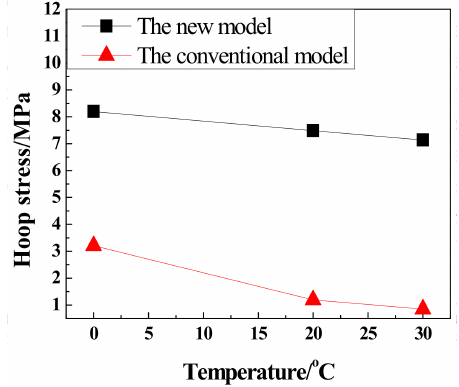
Figure 7. Hoop Stress of cement sheath vs. Temperature.